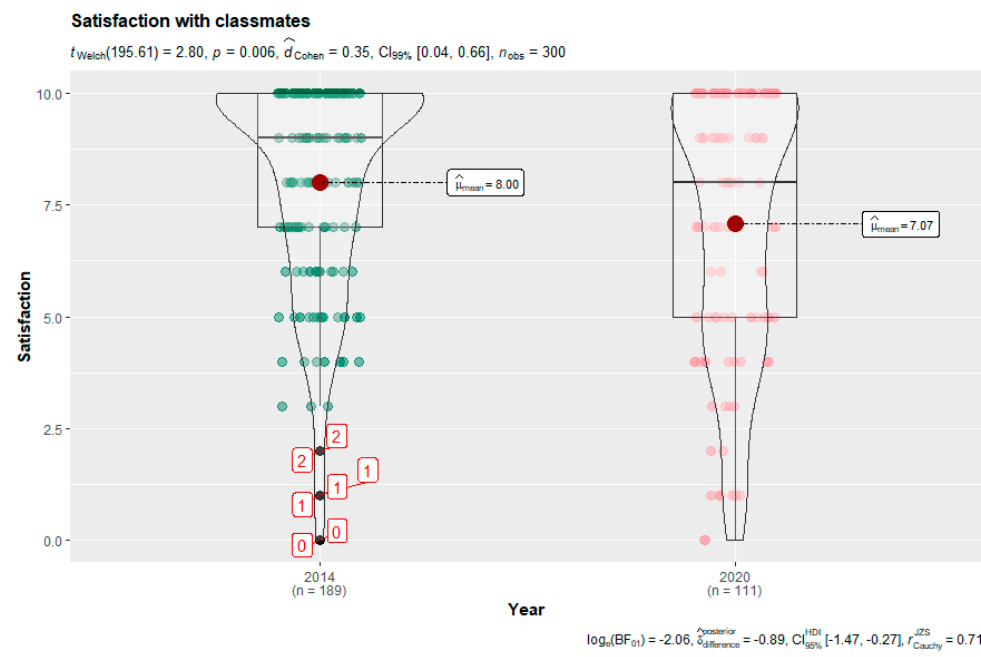
Figure 4. Comparison of means for satisfaction with classmates among boys by year of data collec- tion .